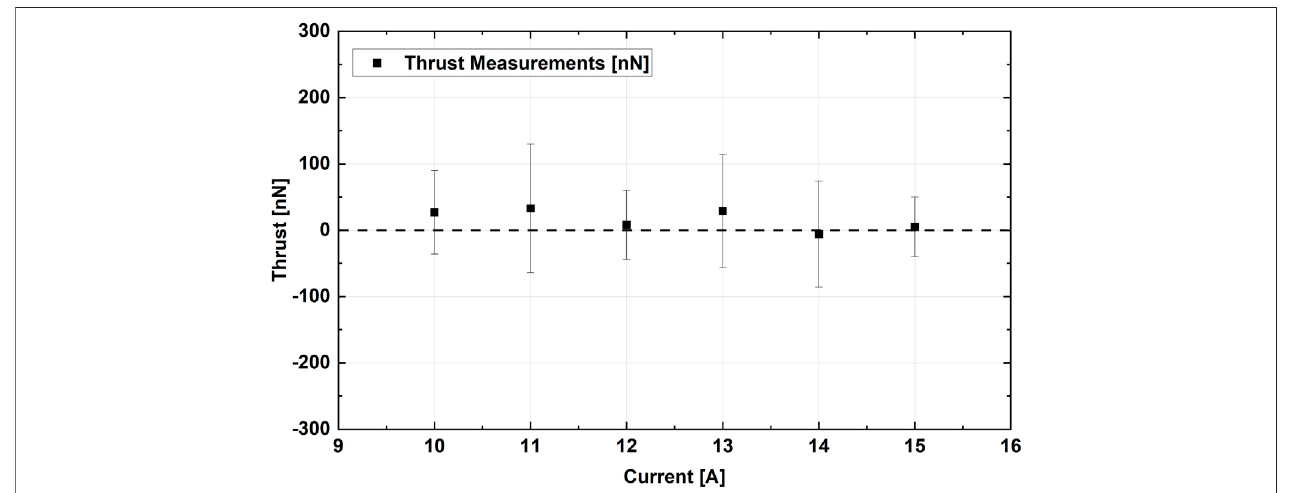
FIGURE 9 | Exemplary thrust measurement of the BSCCO current lead at a maximum current of 15 A.